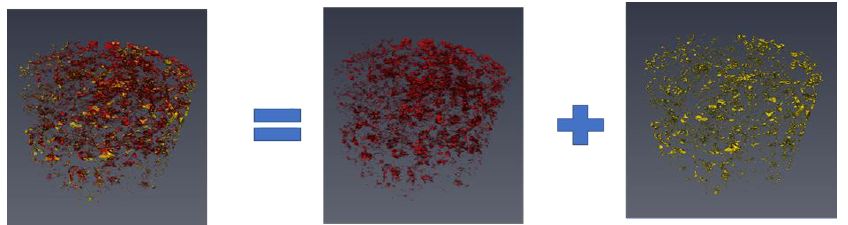
Figure 15. Y53 – 89 core after CO 2 flooding (red is the distribution of crude oil after gas flooding and yellow is the injected CO 2 ).